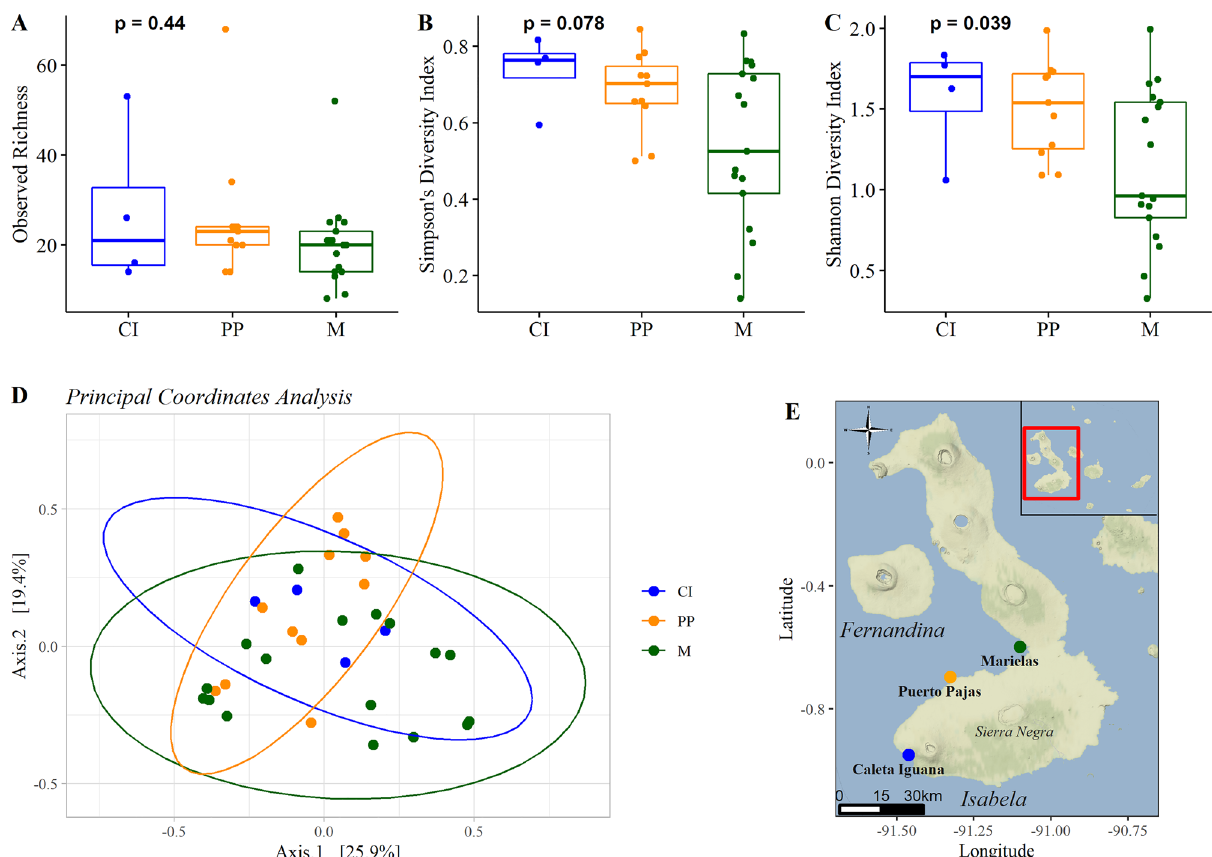
Figure 3. Alpha and beta diversity showed minor variation between samples from the three primary sampling sites on Isabela Island: Caleta Iguana (CI), Puerto Pajas (PP), and Marielas (M). Observed richness and Simpson’s Index were similar between sites ( A , B ), but Shannon Diversity Index significantly differed ( C ). Principal Coordinates Analysis illustrated slight clustering between locations ( D ). Sample sites are shown along the western coast of Isabela Island, with the Galapagos Archipelago in the map inset ( E ). Figure created in R using tidyverse (v. 1.3.1) 96 , phyloseq (v. 1.40.0) 67 , cowplot (v. 1.1.1) 97 , ggpubr (v. 0.4.0) 98 , ggmap (v. 3.0.0) 99 , ggsn